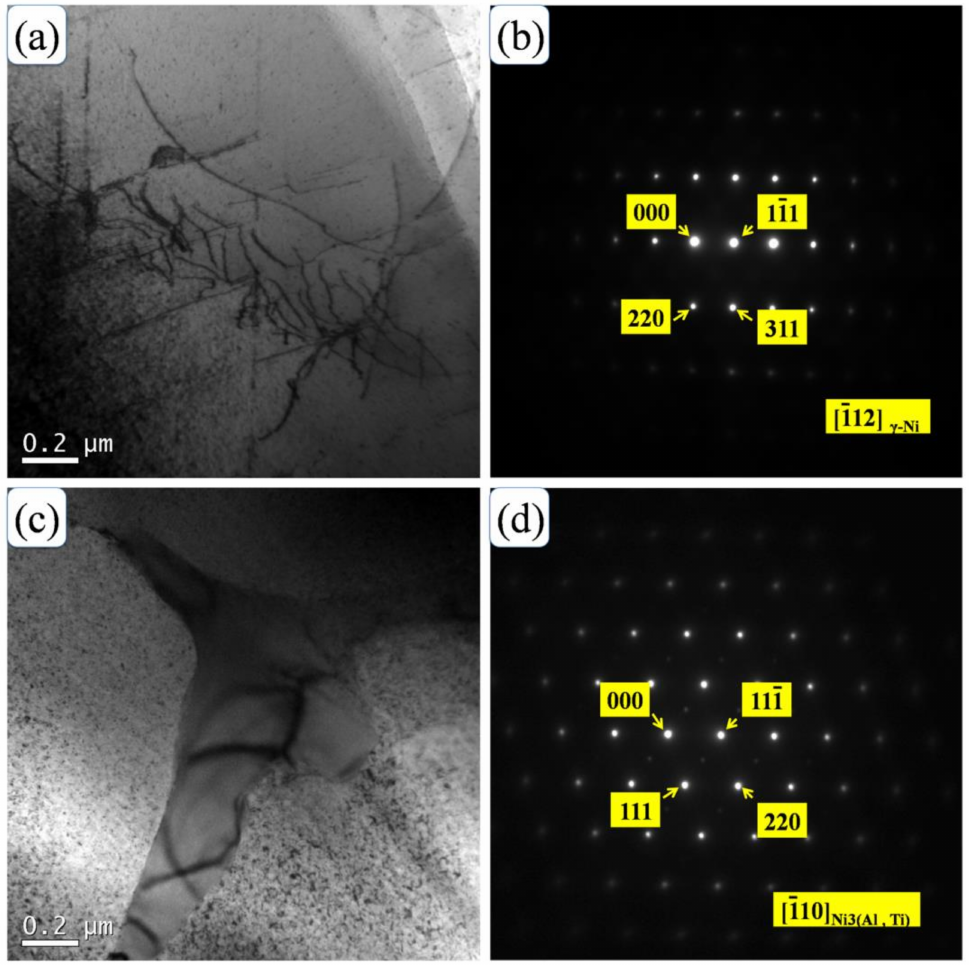
Figure 8. TEM micrographs of the as-cast Ni-Nb5 alloy: ( a ) Bright field image indicating dislocations in the matrix; ( b ) Diffraction pattern of γ matrix in ( a ); ( c ) Bright field image indicating Ni 3 (Al,Ti) phase in the matrix; ( d ) Diffraction pattern of Ni 3 (Al,Ti) phase in ( c ).